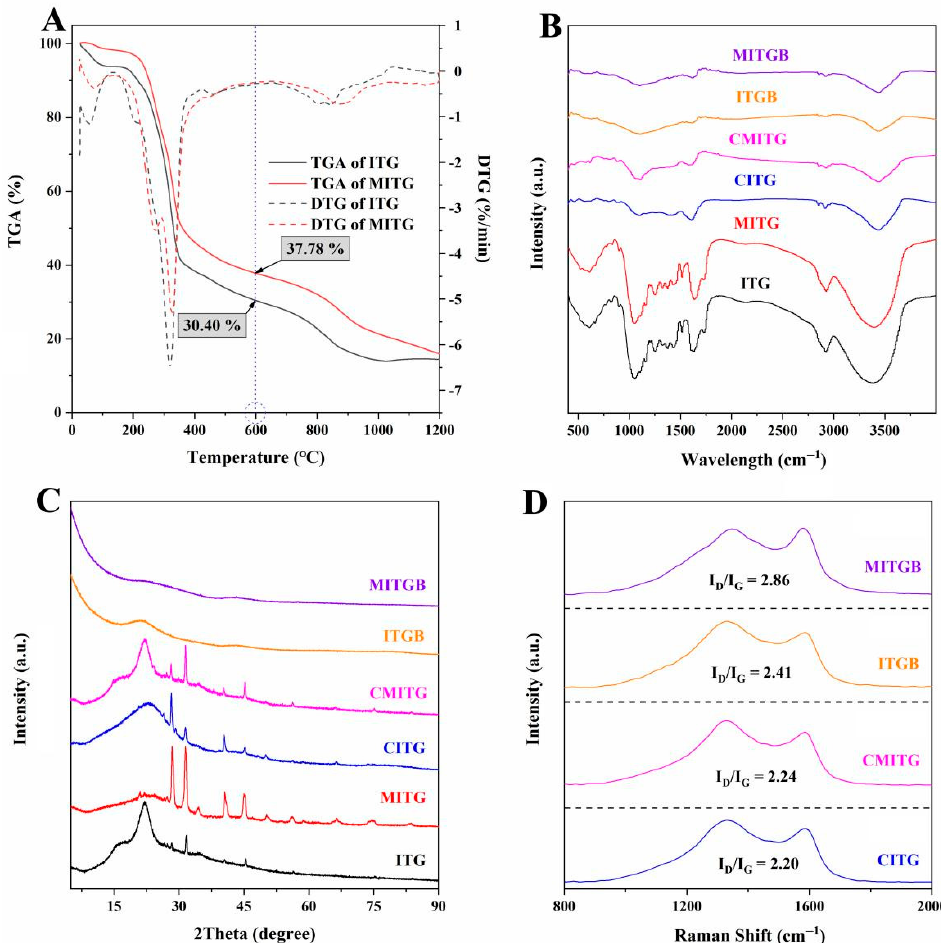
Figure 2. ( A ) TGA curves of ITG and MITG. ( B ) FT-IR spectra and ( C ) XRD pattern of samples. ( D ) Raman spectra of CITG, CMITG, ITGB, and MITGB.